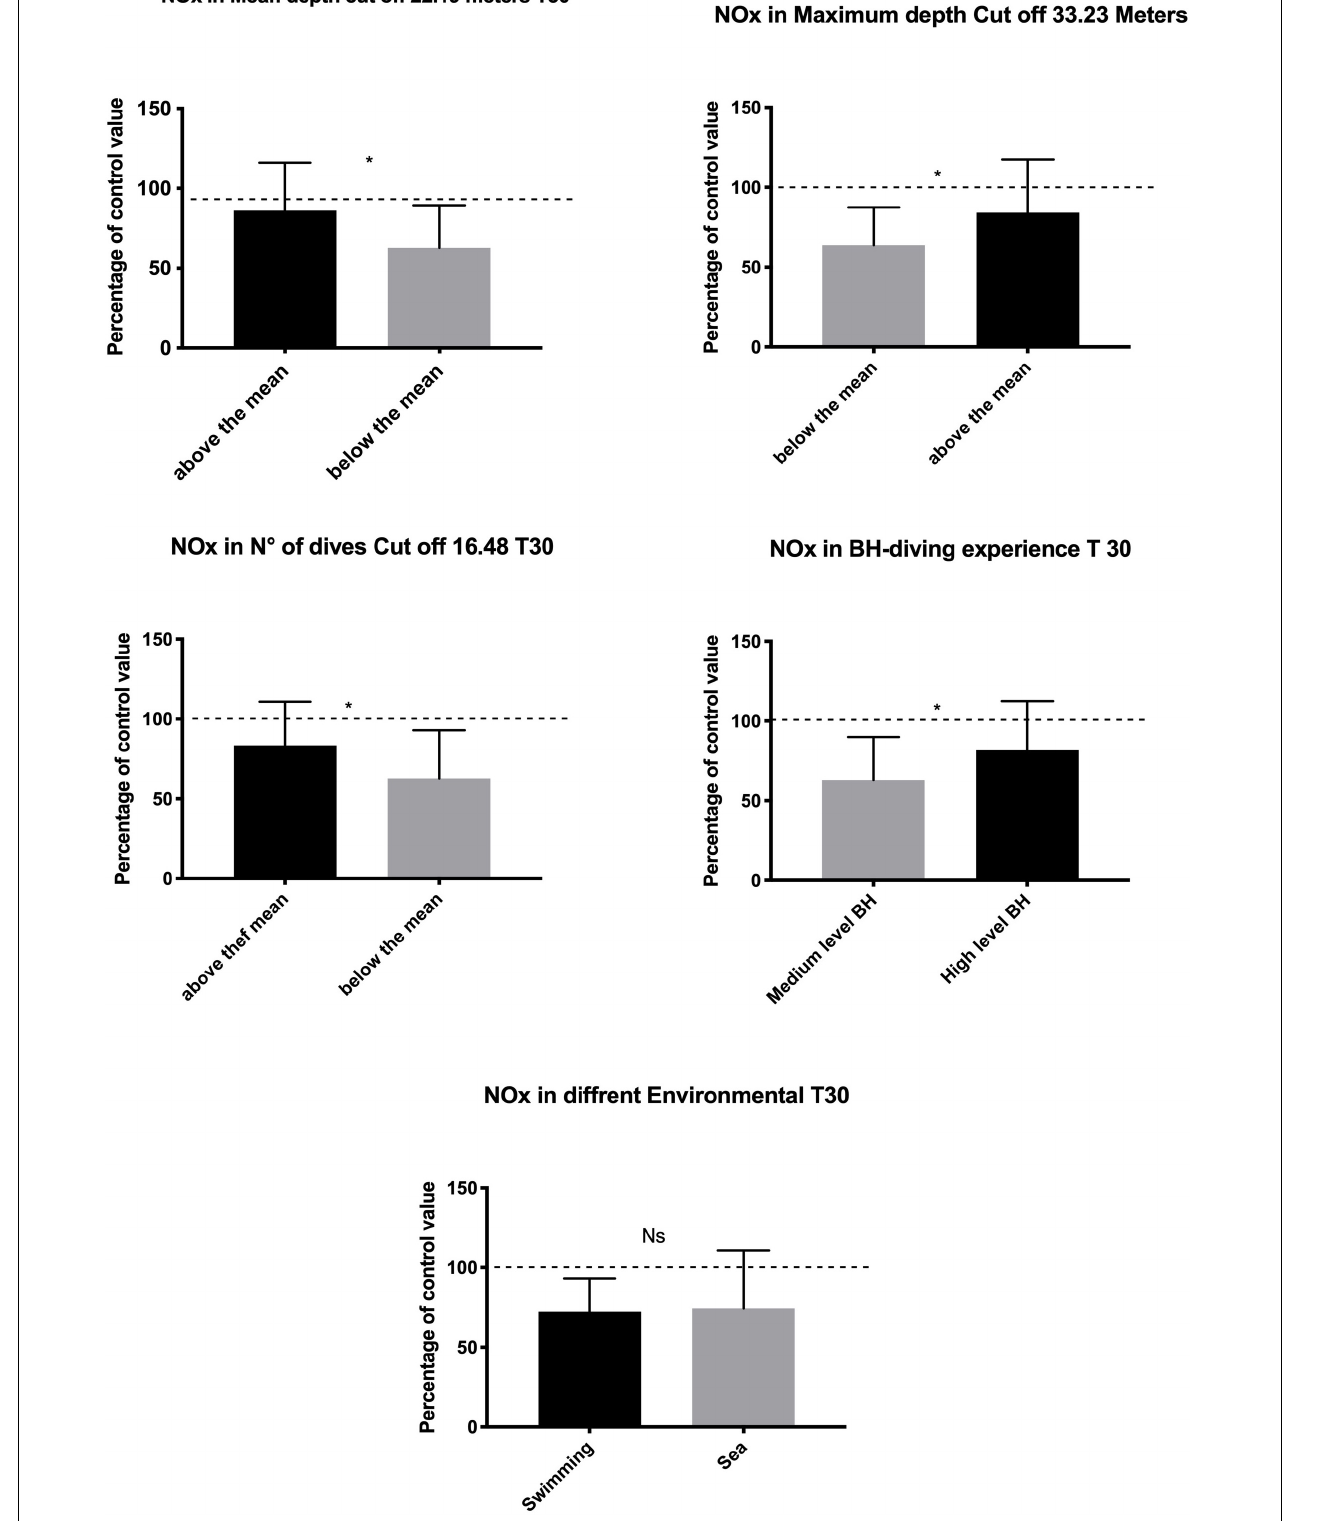
FIGURE 2 | Data at T30 show lower NO usage in highly exposed and experienced subjects indicating adaptation in the management of hyperbaric-related vascular changes. Swimming Pool vs. sea BH-diving data showed no significant differences. * p < 0.05.